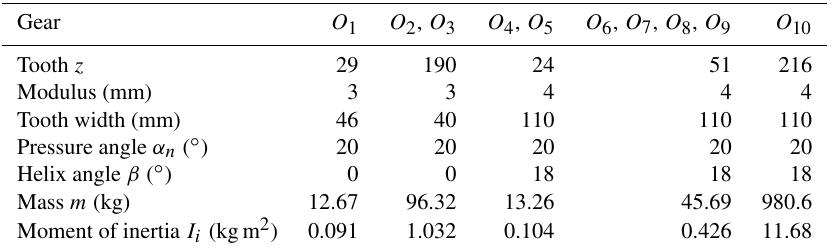
Table 1. Gear parameters.